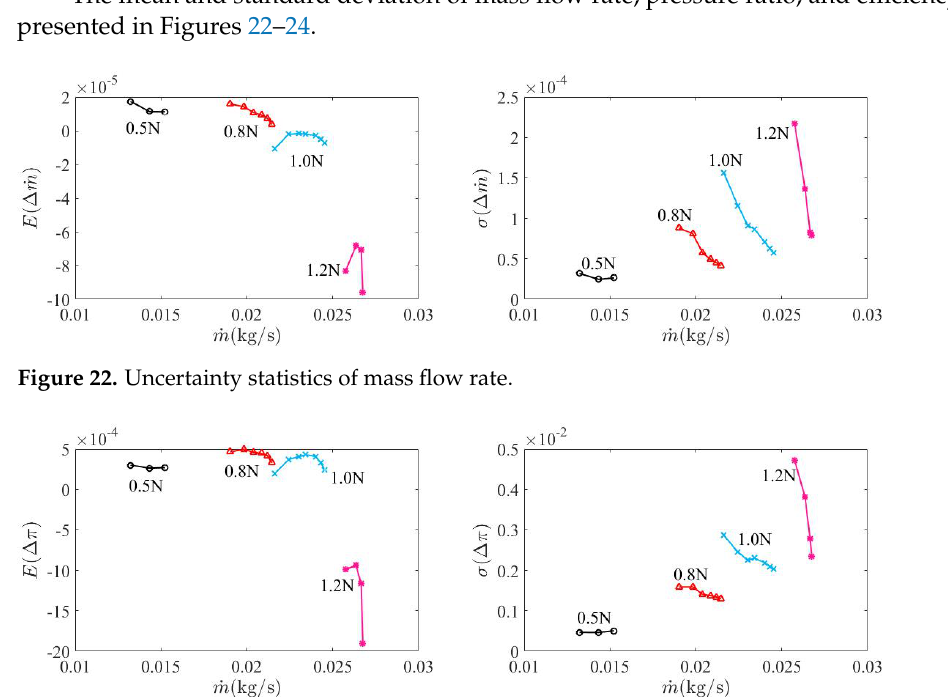
Figure 23. Uncertainty statistics of pressure